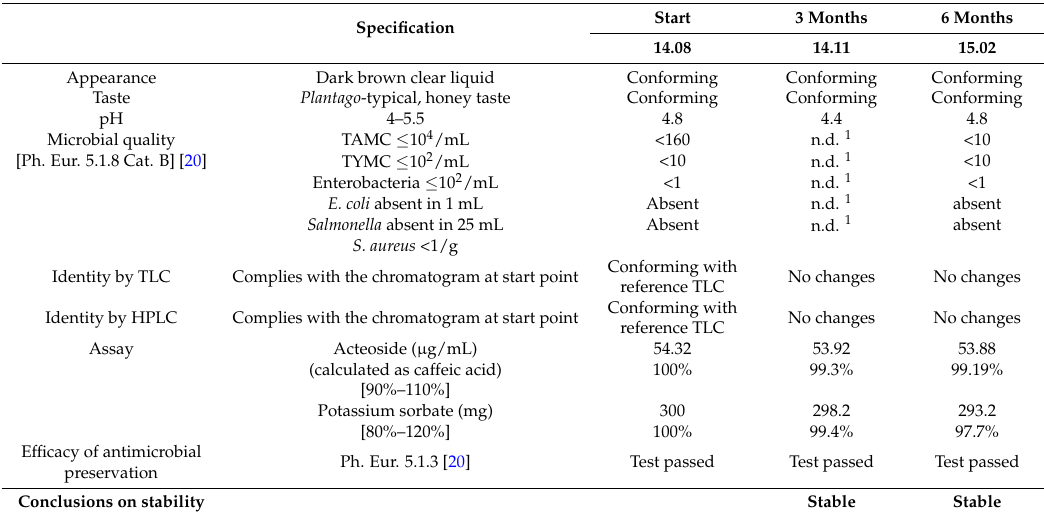
Table 3. Specifications and results of accelerated stability testing of Plantago syrup.